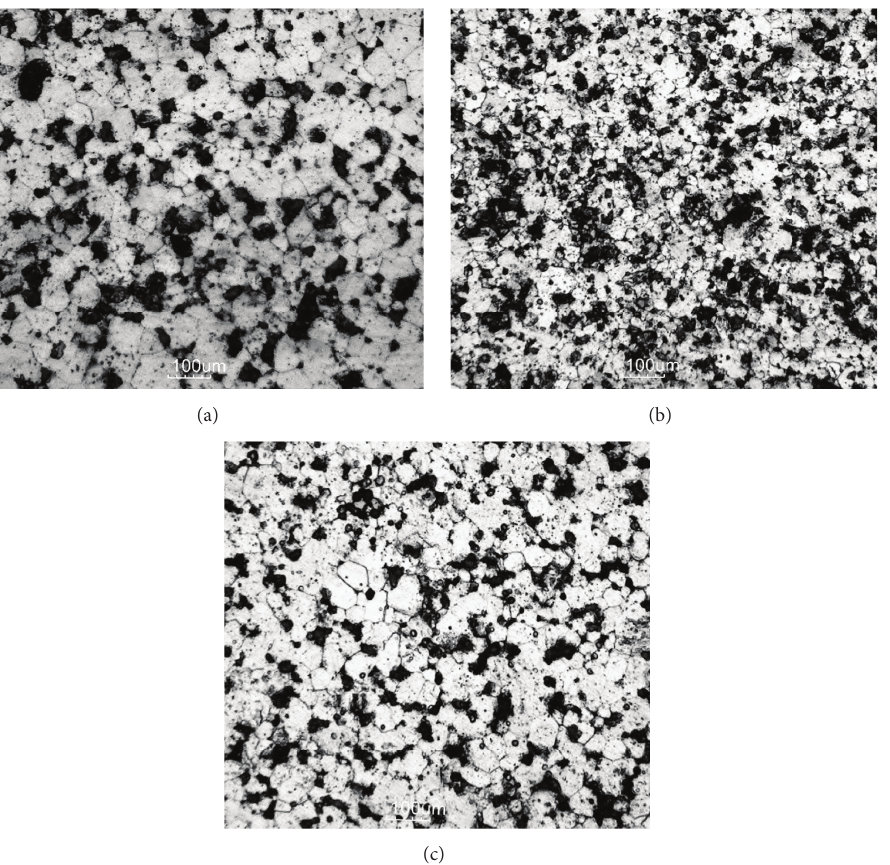
Figure 15: Optical micrographs of Nd magnets: (a) 35Nd, (b) 40Nd, and (c)